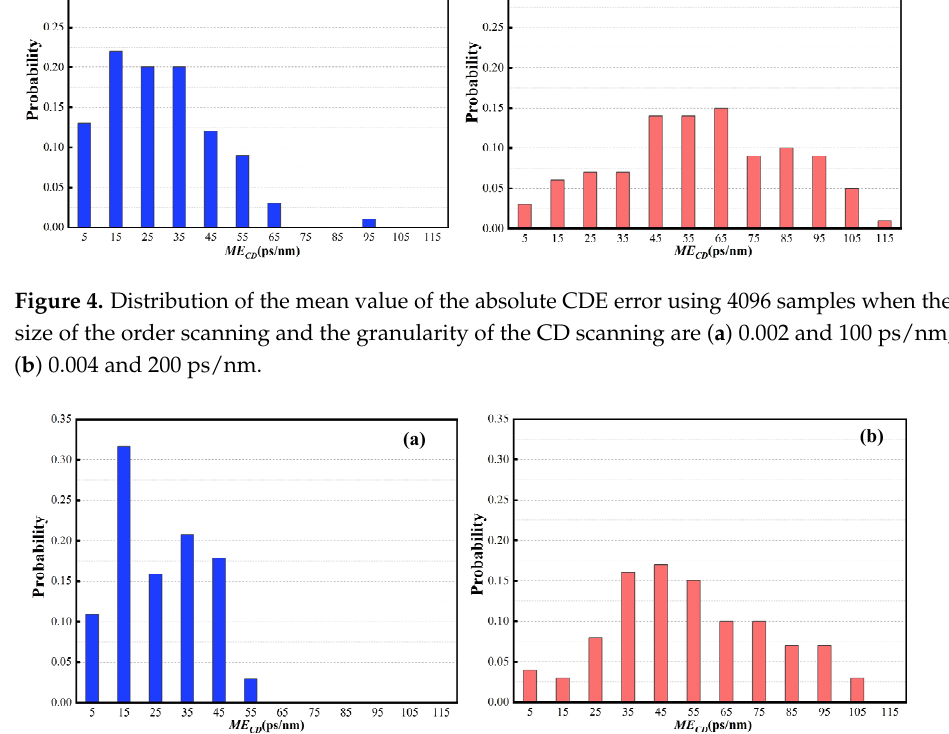
Figure 5. Distribution of the mean value of the absolute CDE error using 8192 samples when the step size of the order scanning and the granularity of the CD scanning are ( a ) 0.001 and 100 ps/nm, and ( b ) 0.002 and 200 ps/nm.